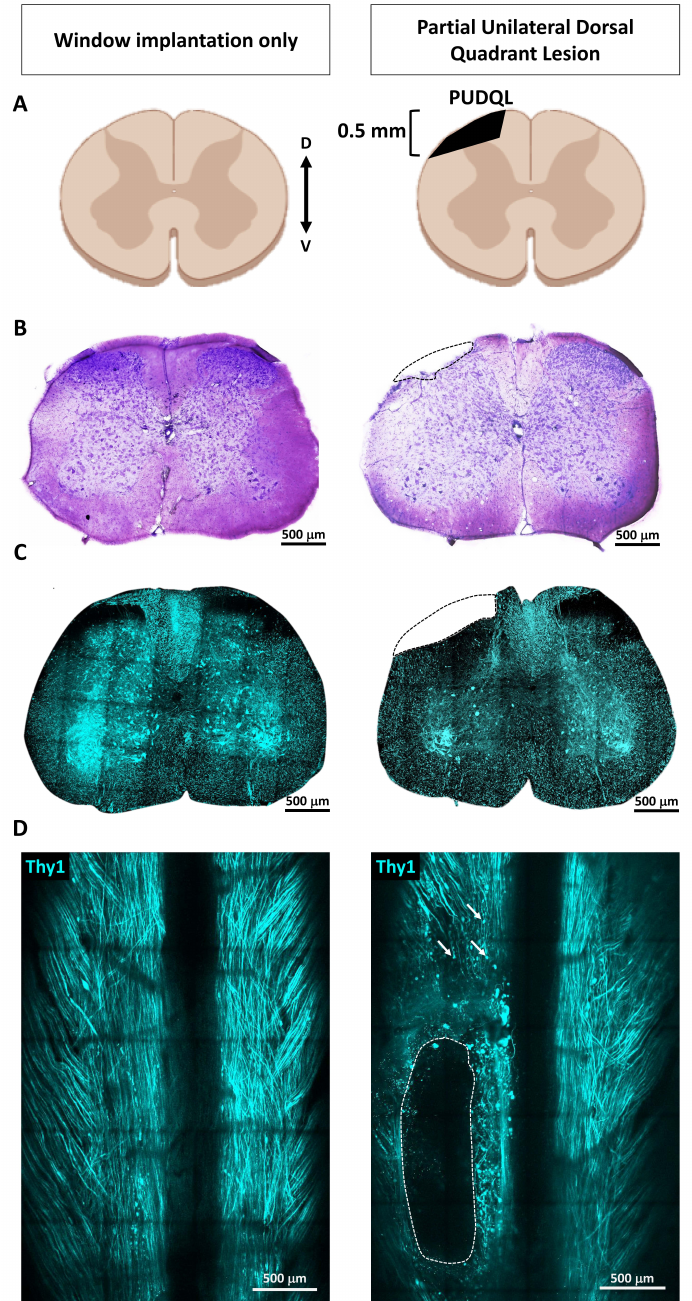
Figure 1. Spinal cord partial unilateral dorsal quadrant lesion (PUDQL) in Thy1-CFP mice. ( A ) Schematic view of the PUDQL (shadowed area in black). ( B ) Cresyl violet staining of transversal spinal cord section collected three days (D3) after window implantation or after PUDQL followed by window implantation. ( C ) Two-photon (2P) fluorescence images of spinal slices consecutive to the one of B). ( D ) Dorsal view of the same Thy1-CFP spinal cord imaged through the implanted window showing the primary lesion area (dotted lines) and examples of subsequent Wallerian degeneration of axons (arrows) on D3. D: dorsal; V: